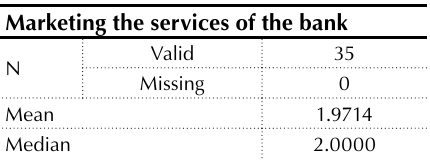
Table 4. Statistical test: